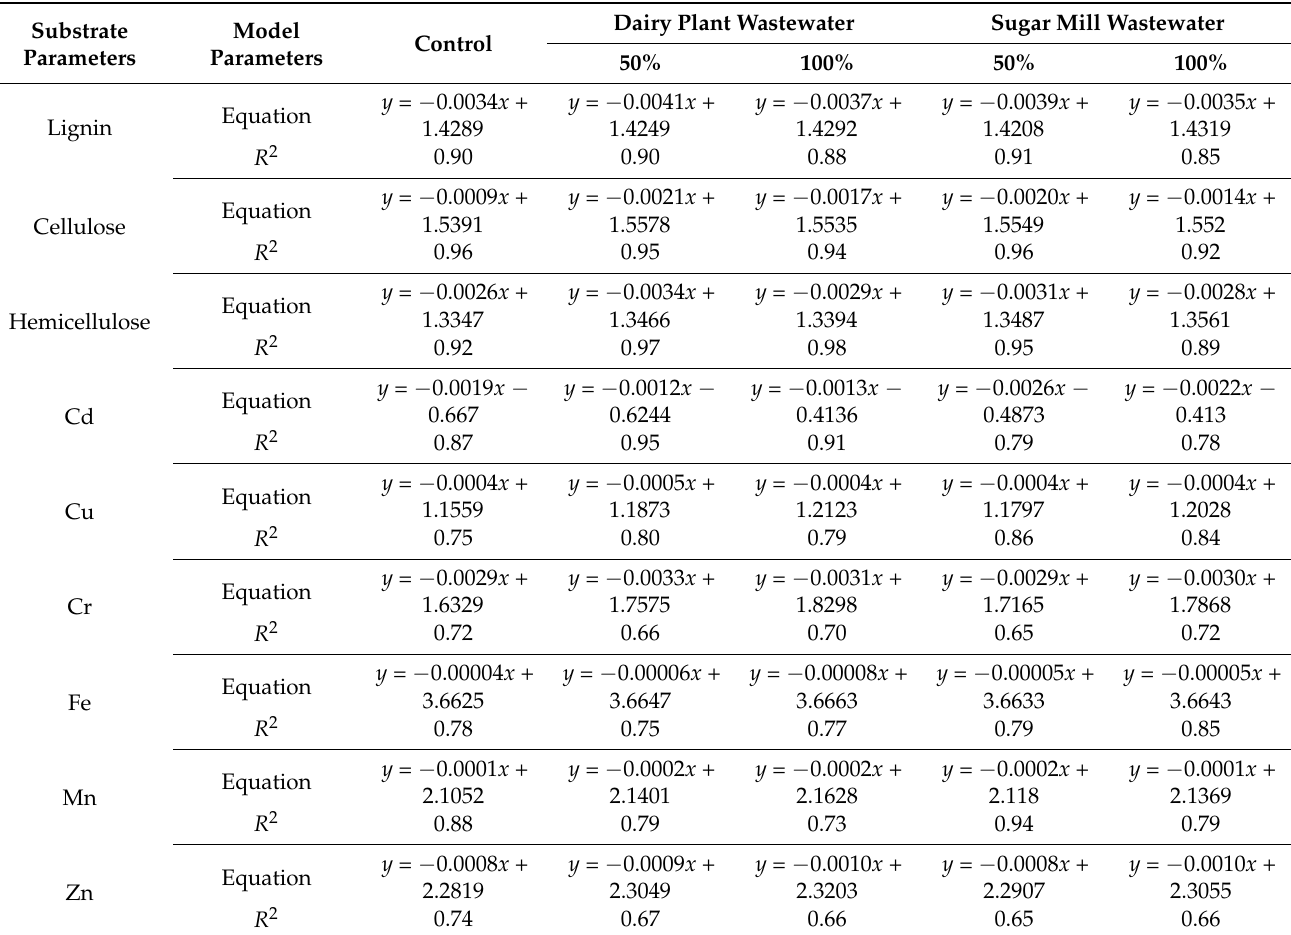
Table 5. Kinetic parameters of delignification and heavy metals uptake by Shiitake ( L. edodes ) mushroom cultivated on agro-industrial wastewaters treated